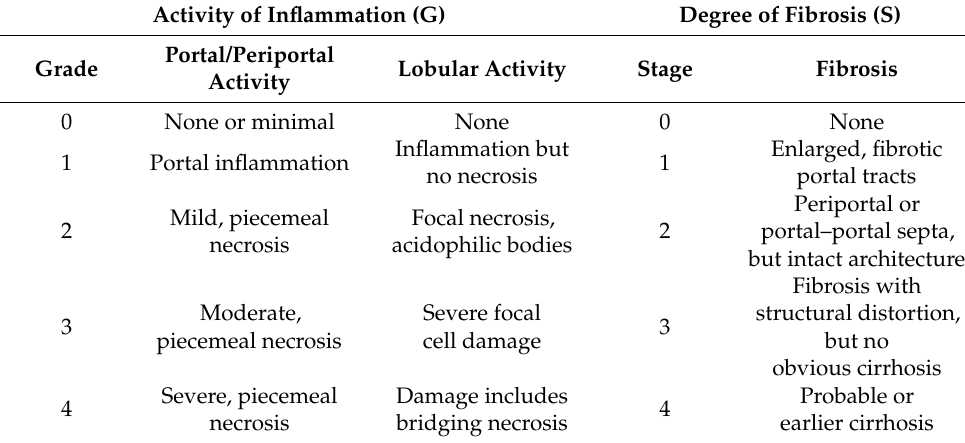
Table 1. Criteria of the Scheuer